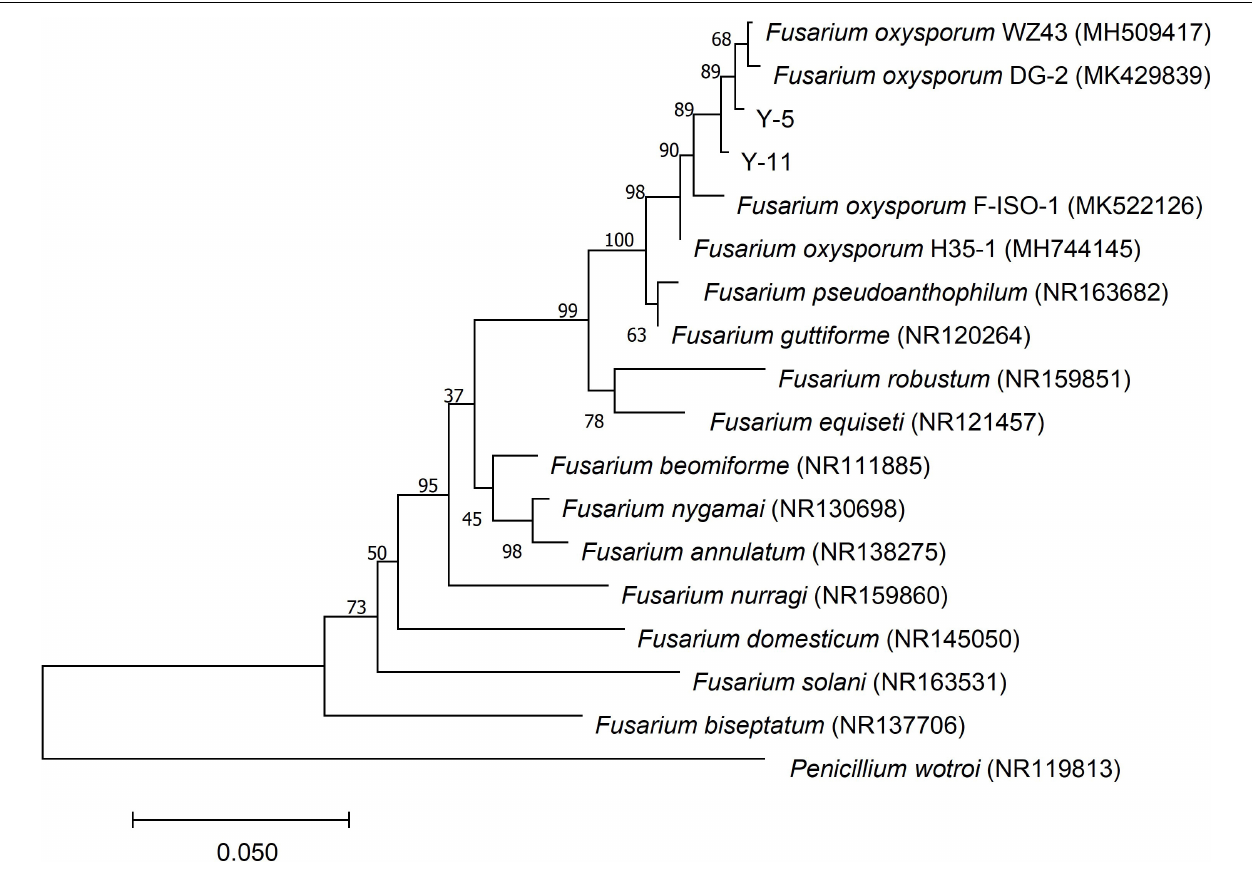
FIGURE 3 | Phylogenetic tree constructed based on ITS sequence of pathogenic fungi Y-5 and Y-11.